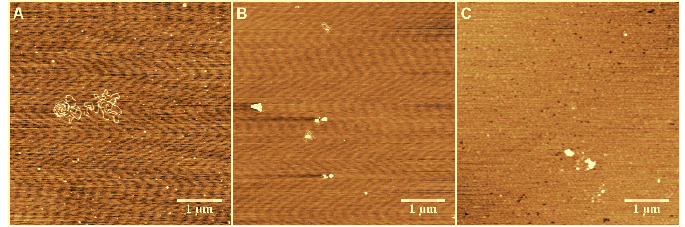
Figure 3. The structure of DNA in mixture solution of various concentrations (( A ) 0.1 mM; ( B ) 0.5 mM; ( C ) 1 mM) of As + and 1 mM Mg 2+ . Polymers 2017 , 9 , 128